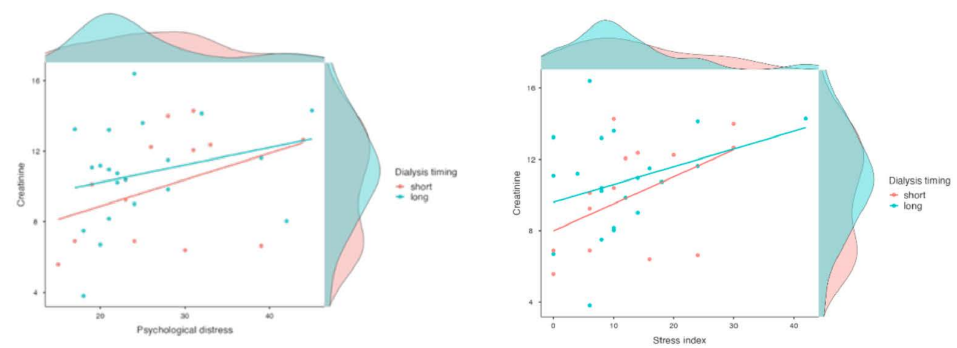
Figure 2. Scatter plots of negative emotions in dialysis groups divided by (median value) timing of